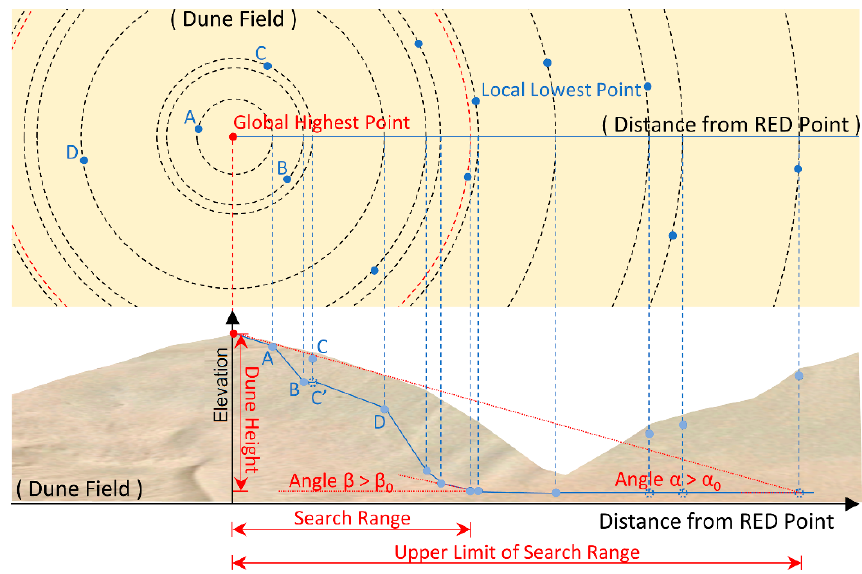
Figure 2. Sketch map of the algorithm for the dune